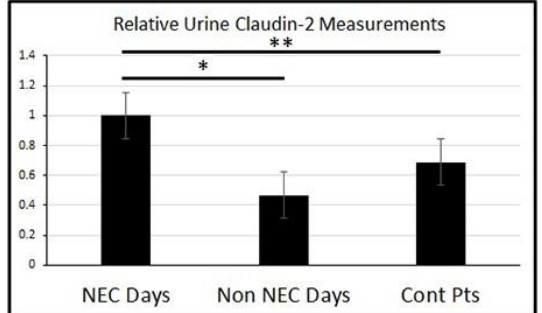
Figure 3: Patients had nearly double the measurement of urinary claudin-2 during periods of active NEC vs. NEC free periods (*p<0.0001). The elevated urinary claudin-2 levels were also significantly higher than the control patients